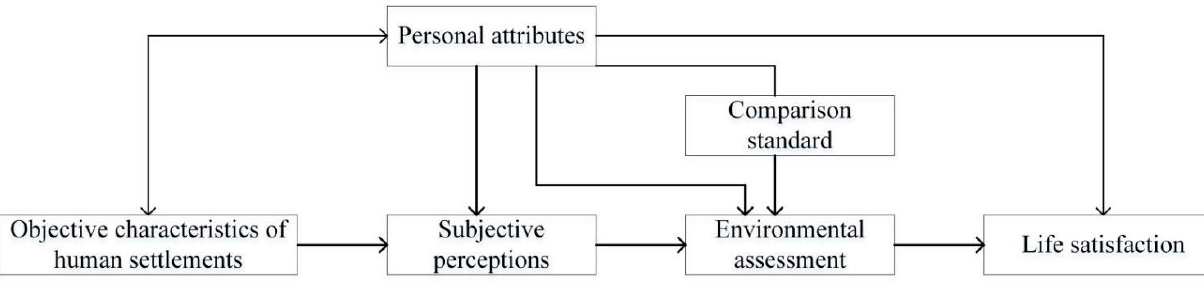
Table 1. Description of related variables.